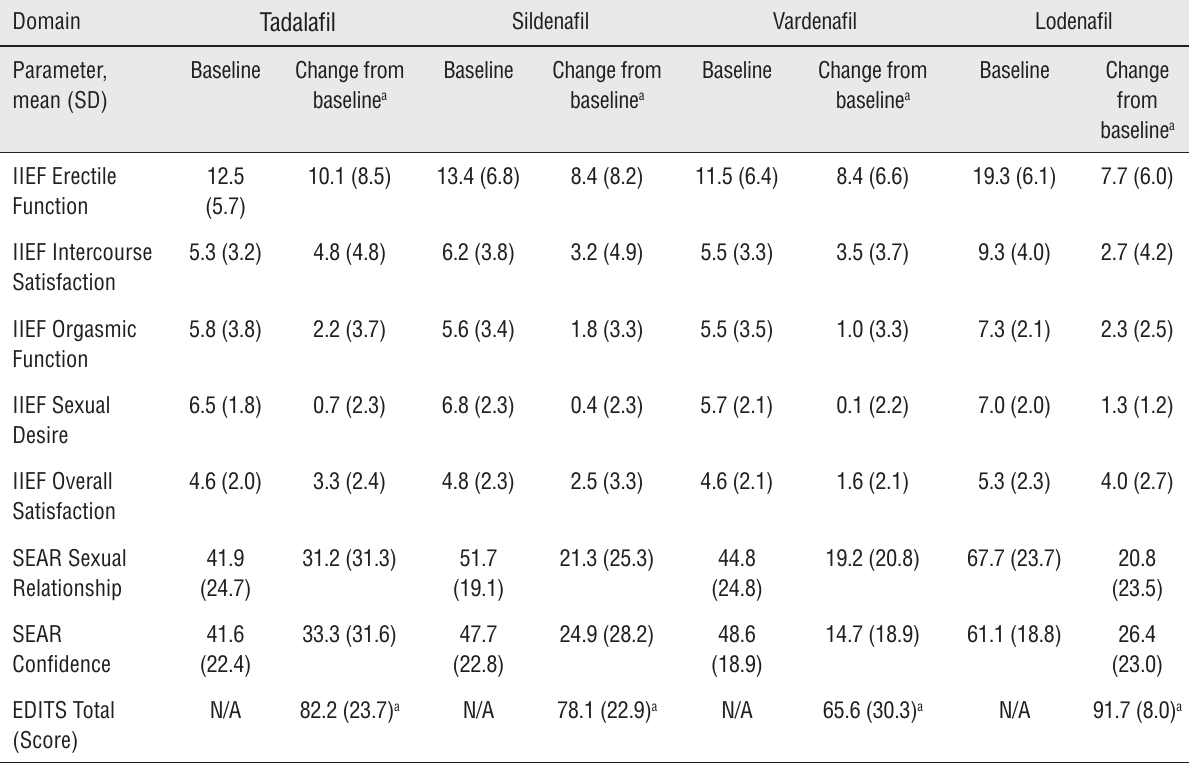
Table 5 - Measures of Therapeutic Effectiveness - Results for IIEF, EDITS, and SEAR at Baseline and 6 Months.